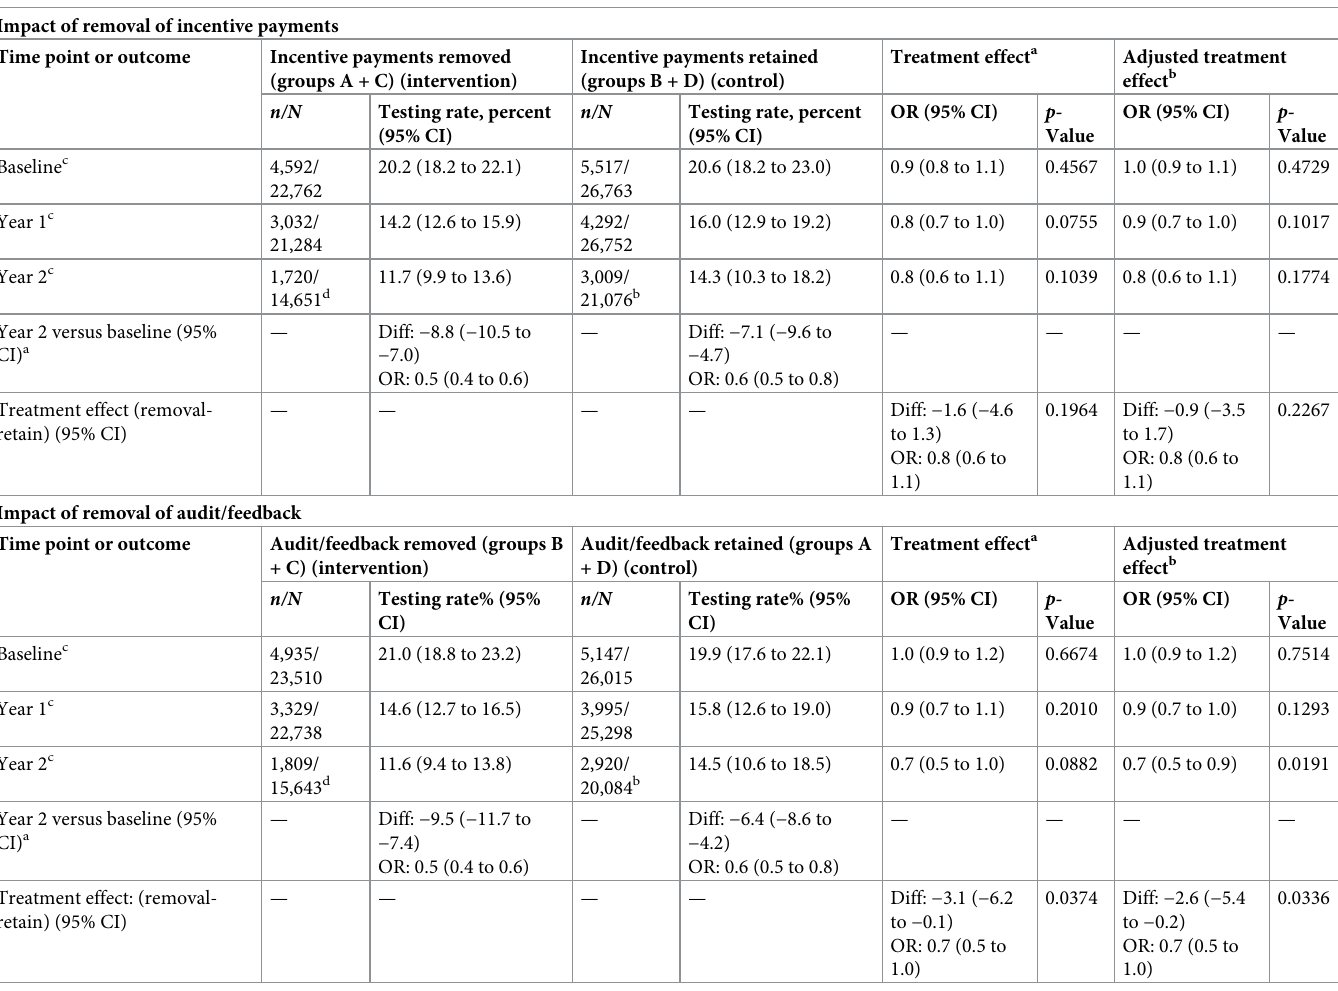
Table 2. Primary outcome chlamydia testing—factorial